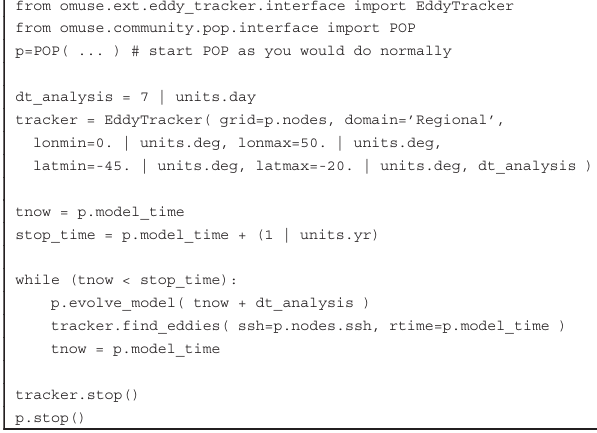
Figure 19. This example demonstrates how to build an application that analyzes data from a running simulation using OMUSE. This code implements an online eddy-tracking program that tracks the eddies based on sea surface height every 7 days for 1 year of POP